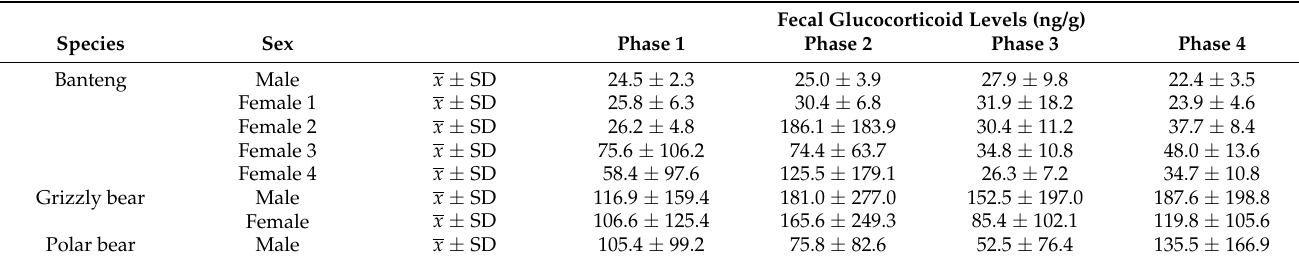
Table 5. Means and standard deviations for fecal glucocorticoids by phase for individual banteng, grizzly bears, and the polar bear.